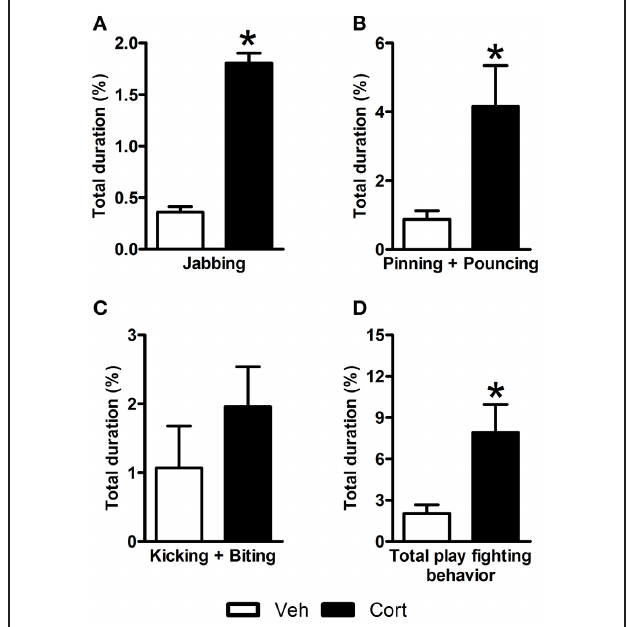
FIGURE 2 | Effect of corticosterone injections during peripuberty on play behavior. (A) Percent duration of jabbing. (B) Percent duration of pinning and pouncing. (C) Percent duration of kicking and biting. (D) Percent duration of total play fighting behavior. The results are expressed as mean ± SEM; ∗ p < 0 . 05; N =